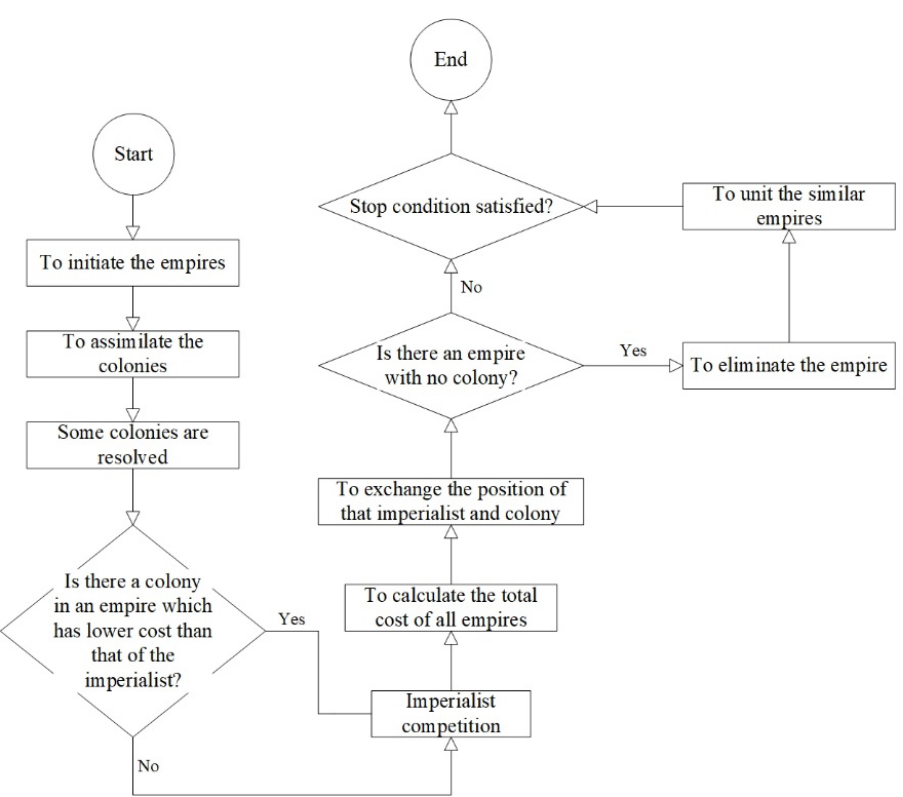
Figure 2. A schematic representation of the ICA algorithm. Mean square error (MSE) = 1